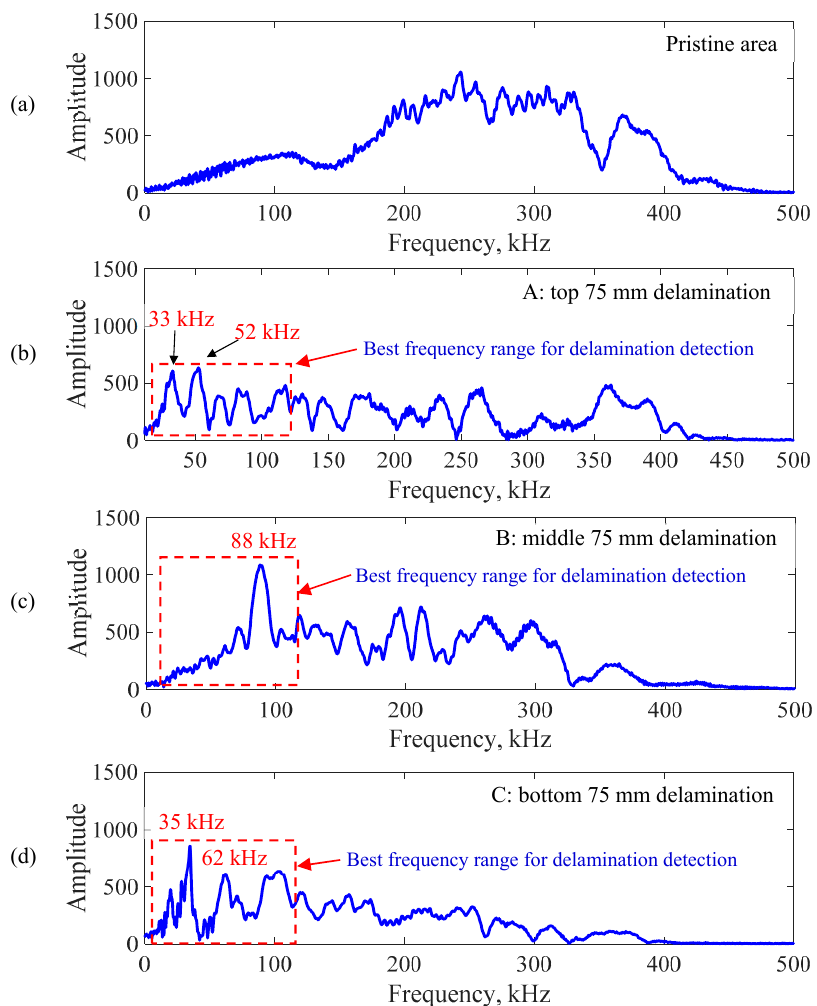
Figure 13. Frequency spectrum of the response signals at the center point of different scanning areas: ( a ) pristine area; ( b ) top 75 mm delamination A; ( c ) middle 75 mm delamination B; ( d ) bottom 75 mm delamination C. Table 3. Resonance frequencies of the delaminations at different depths in the unidirectional [0] 30 CFRP composite plate.